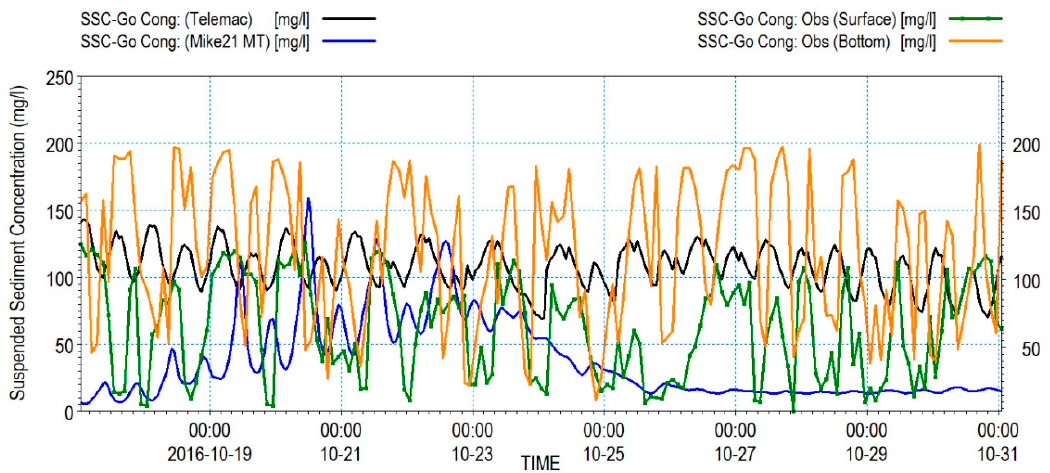
Figure 6. Comparison between the computed and measured values of suspended sediment concentrations at the Go-Cong surveying site (16–31 October 2016).